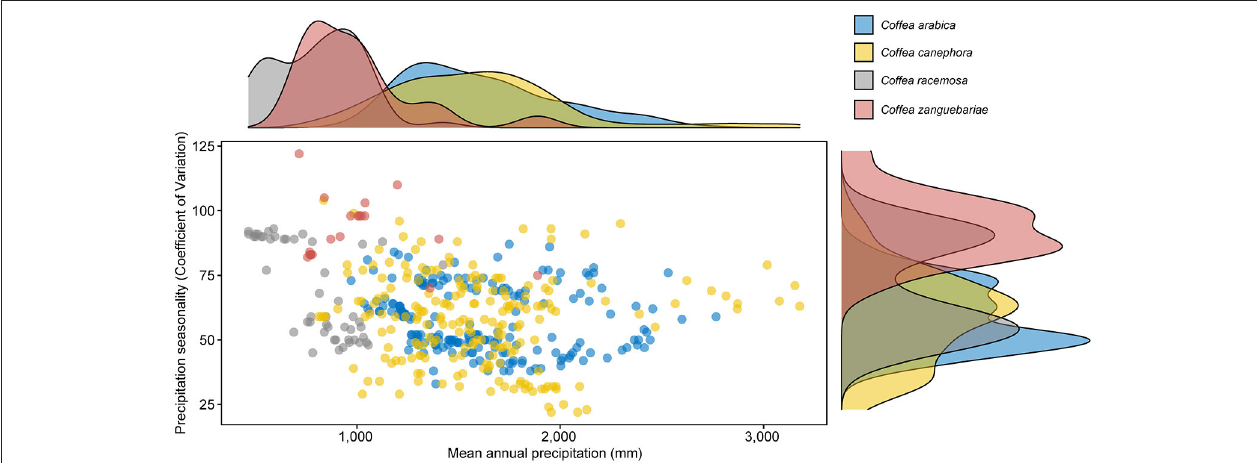
FIGURE 9 | Scatter and density plots of modelled total mean annual precipitation (CHELSA bio10_012) vs. precipitation seasonality (CHELSA bio10_015). Mean values in parentheses: Arabica ( C. arabica ; 1,614 mm/58); robusta ( C. canephora ; 1,596mm); wild and cultivated C. racemosa (807 mm/69) and wild and